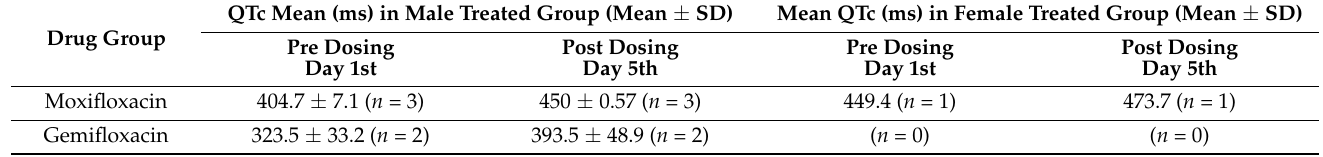
Table 2. Gender effect of moxifloxacin and gemifloxacin on QTc interval. QTc Mean (ms) in Male Treated Group (Mean ± Drug Group